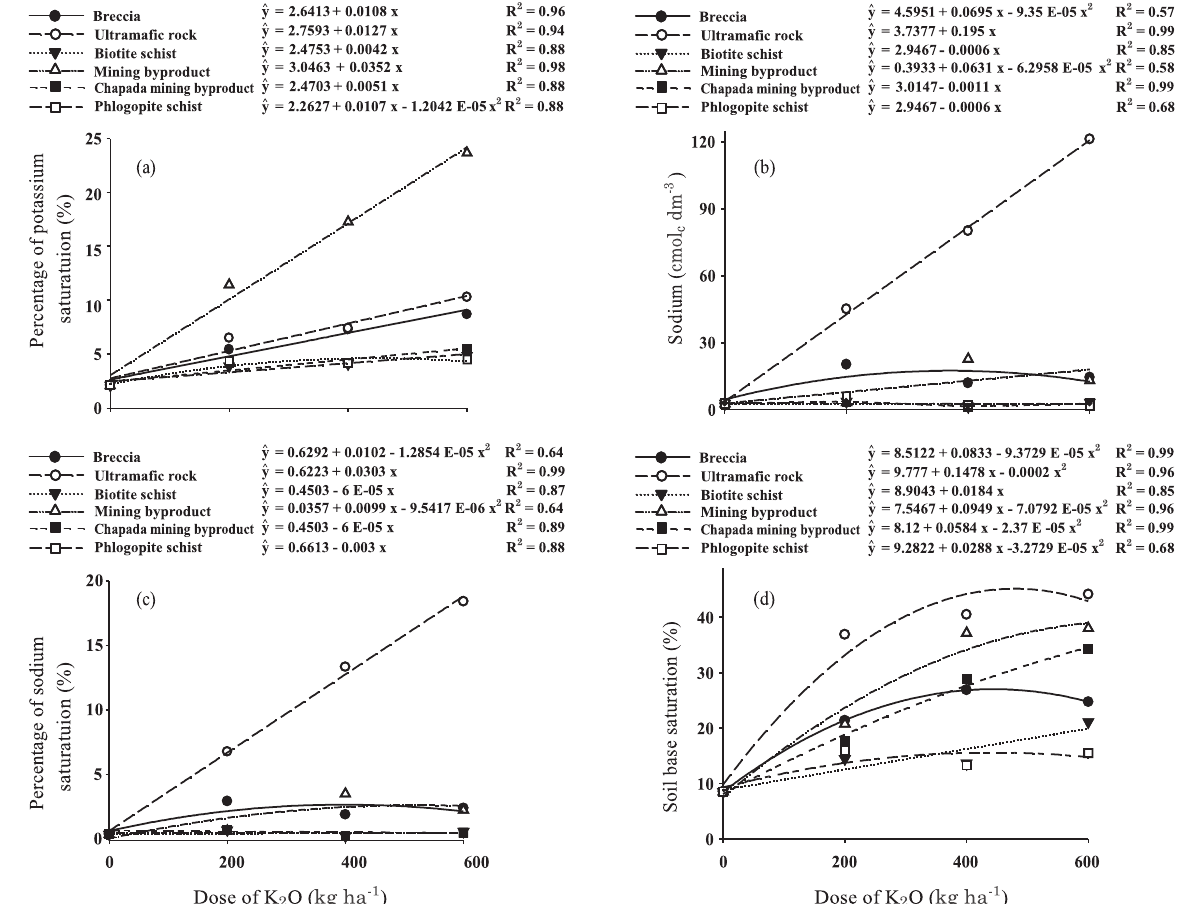
figure 4. Potassium saturation (a), sodium availability (b), sodium saturation (c) and base saturation (d) of soil fertilized by breccia, ultramafic rock, biotite schist, mining byproduct, Chapada mining byproduct and phlogopite